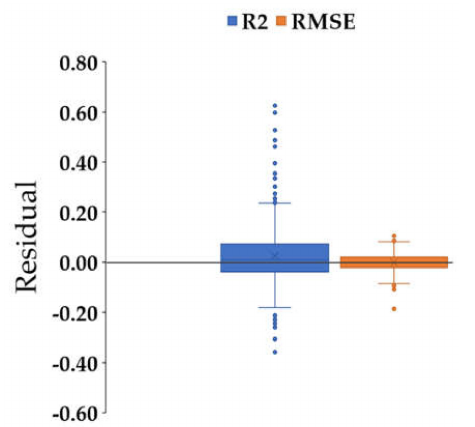
Figure 8. Boxplot for the residual between pooled training and testing RMSE and R 2